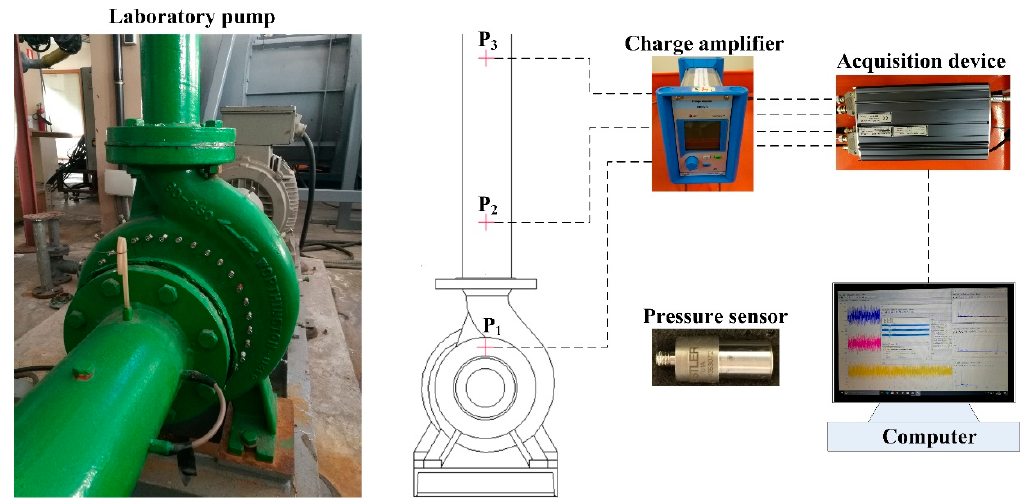
Figure 1. Schematic view of the experimental